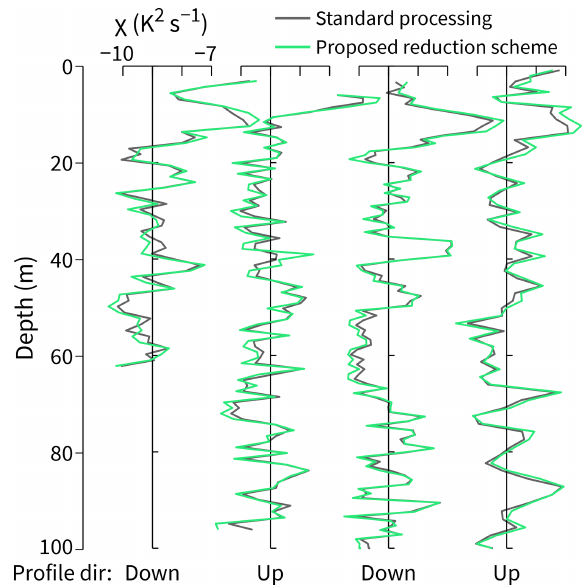
Figure 8. Testing the proposed data reduction scheme for fast- thermistor measurements. The profiles used are the same as those chosen in Fig. 5.